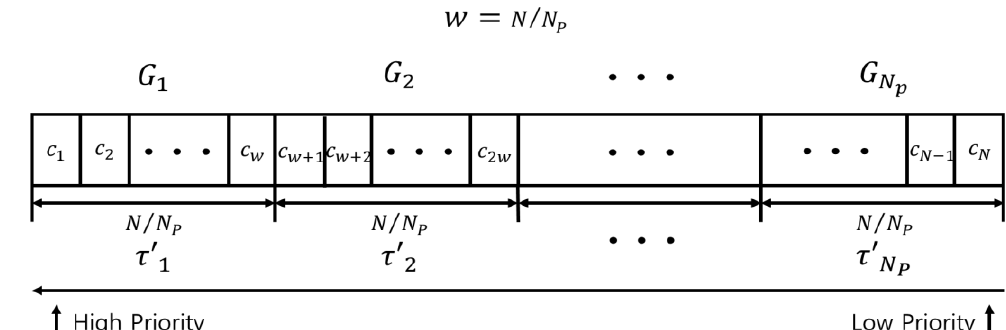
Figure 7. Composition of the code word by priority.